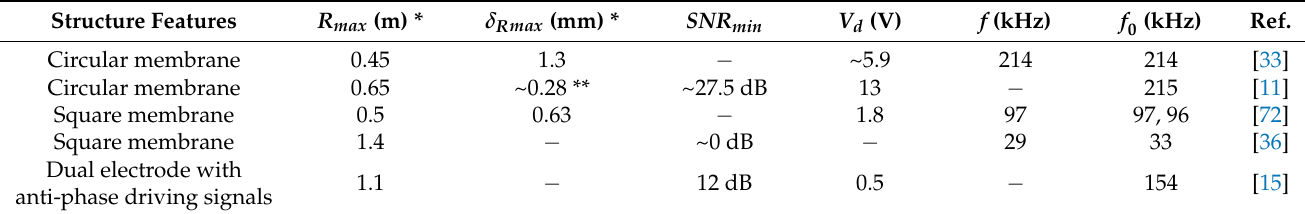
Table 4. Summary of pMUT rangefinders with different device structures.